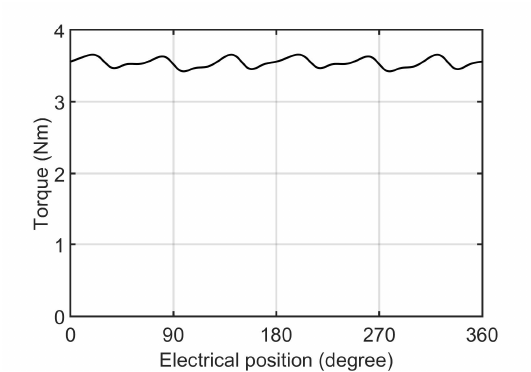
Figure 18. Torque waveform at rated condition, one channel